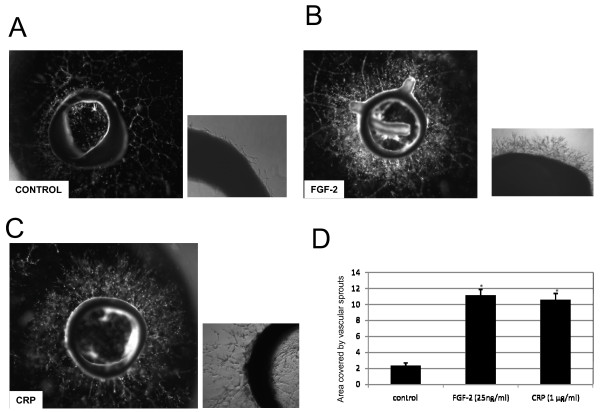
Aortic ring assay. A, control. B, Incubated with FGF-2 (25 ng/ml). C, Incubated with 1 μg/ml of detoxified CRP [CRPdt]. D, Bar graphs showing area covered by vascular sprouts in control, FGF-2 (25 ng/ml) and CRPdt (1 μg/ml).